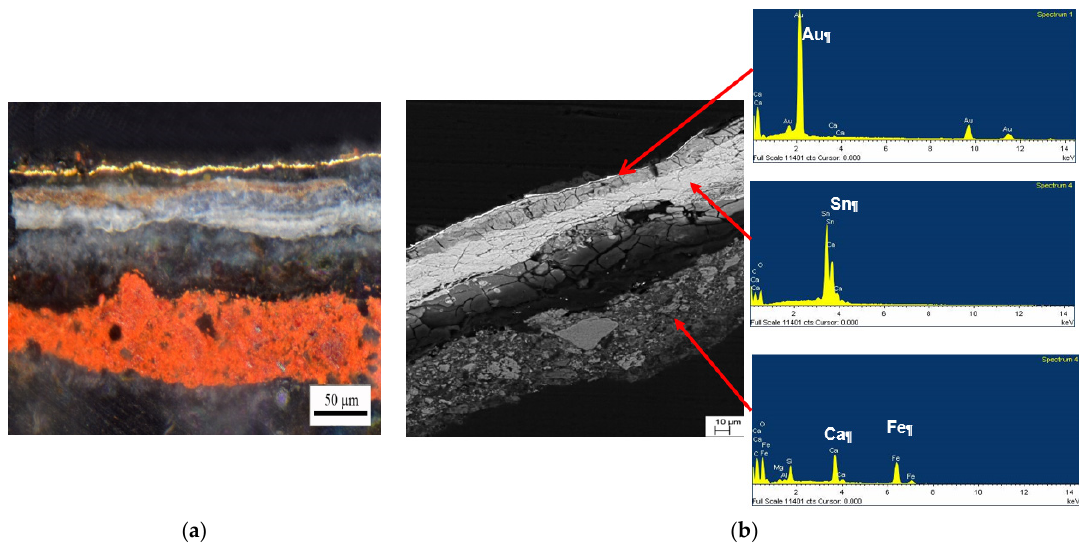
Figure 5. ( a ) OM image of sample B, reflected light, dark field. ( b ) FESEM image and EDX spectra of sample B (gold foil on tin lamina). The gold leaf is visible as a brighter, thin region on top of a thicker region corresponding to tin. (b) The EDX spectra measured on the gold leaf (spot analysis), on the tin lamina and on the preparation layer (analyzed area ca. 20 × 20 µm 2 ).